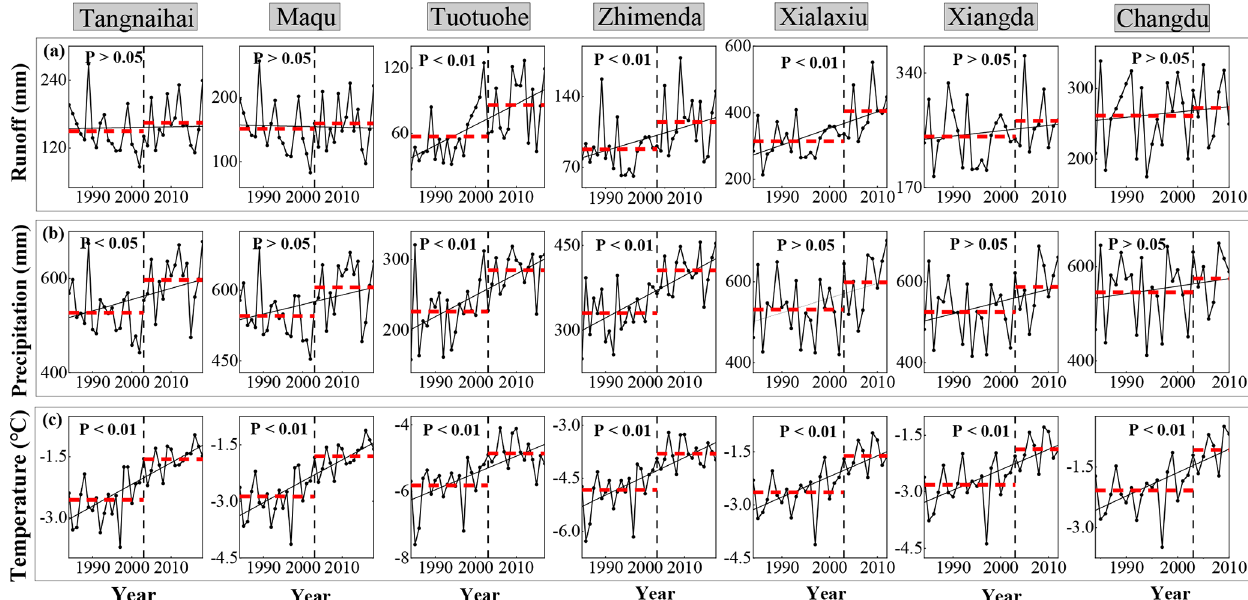
Figure 6. Annual runoff (a) , precipitation (b) , and temperature (c) for the seven sub-basins. The dotted red lines represent the annual average of each variable in the reference period (1984–2003) and the changed period (2004–), respectively. P < 0 . 05 and P < 0 . 01 indicate that the trend is significant at the level of 0.05 and 0.01, respectively, using the Mann–Kendall trend